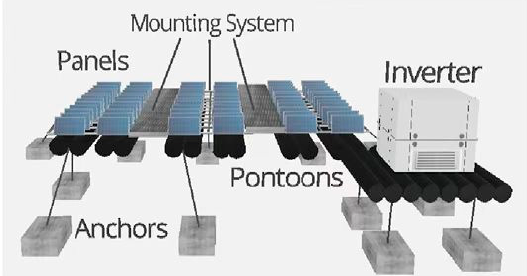
Figure 3. A standard large-scale floating PV system with major components [32]. Reprinted with permission from Ref. [Life cycle assessment of a floating photovoltaic system and feasibility for application in Thailand]. 2021, Clemons, S.K.C.